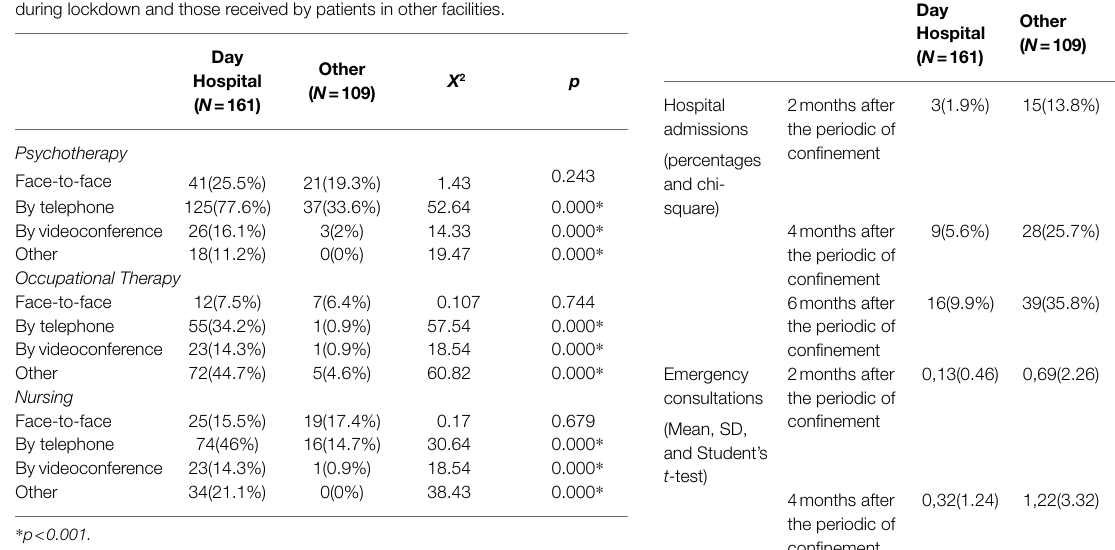
TABLE 2 | Differences between the psychotherapeutic, occupational therapy, and nursing interventions received face-to-face, by telephone, by videoconference, or by other telematic means by patients treated in MHDHs during lockdown and those received by patients in other facilities.